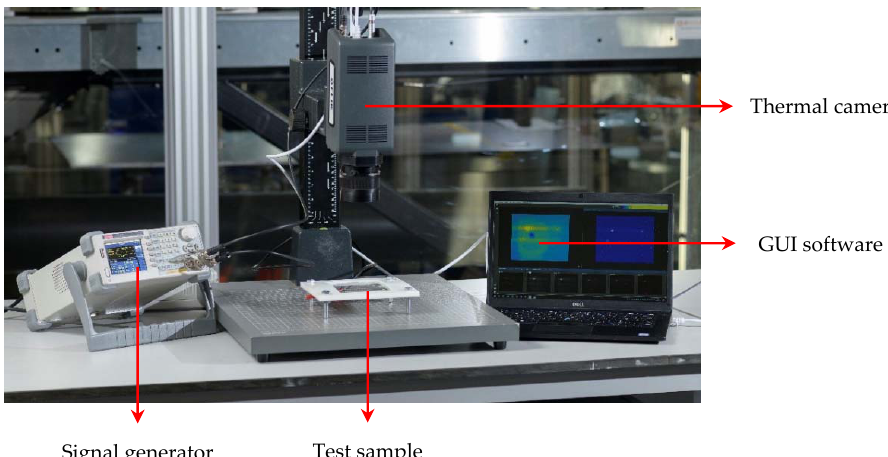
Figure 1. DLIT system set-up.